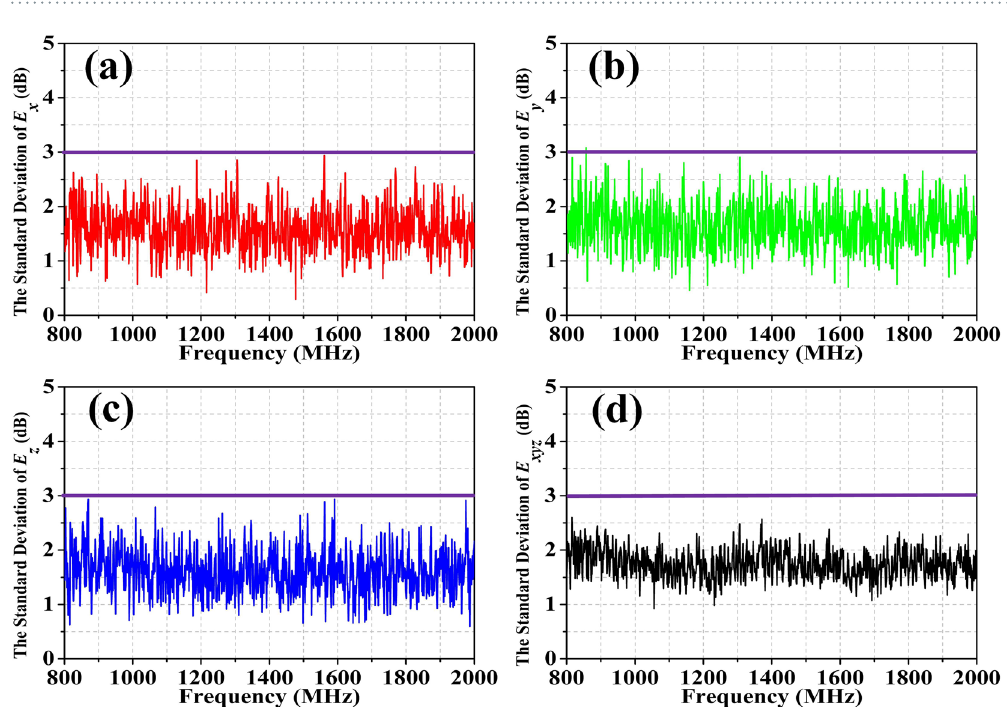
Figure 8. The standard deviations for the field uniformity of the test zone that is loaded with the fixed 1-bit random coding diffusion metasurface in the mechanical RC. The purple lines are the tolerance requirements for the standard deviation of; 13 ( a ) the x-component, ( b ) the y-component, ( c ) the z-component, ( d ) the combination of xyz